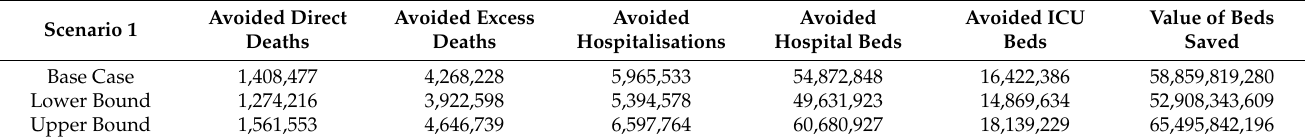
Table 6. Estimates of the value of vaccines including ranges based on +/ − 5 percentage point input values for vaccine efficacy.